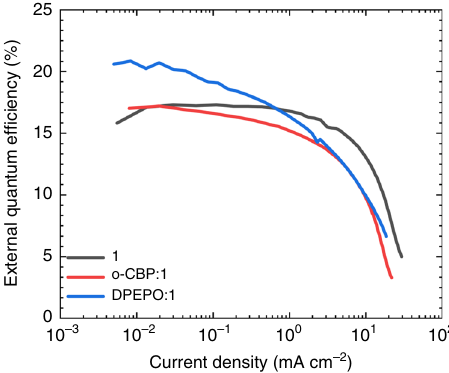
Fig. 6 Electroluminescence external quantum ef fi ciency. External quantum ef fi ciency of OLEDs based on 1 as a function of current density in host-free and host-guest